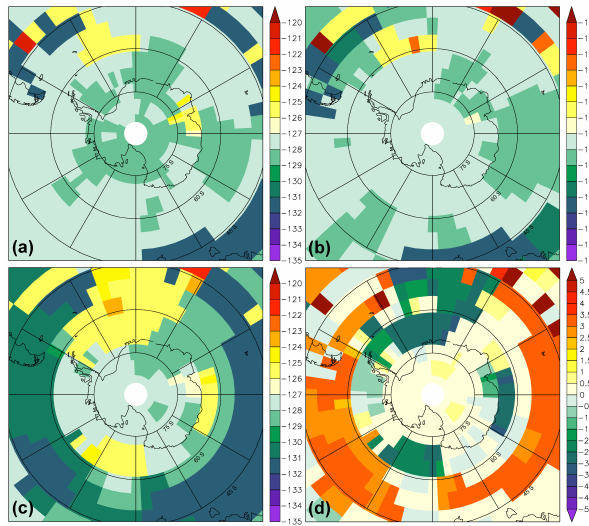
Figure 9. Time of maximum surface air temperature (MWT) in kyrBP for experiments Reference (a) , noGfwf (b) , and noAGfwf (c) and difference in MWT between experiments noGfwf and noAGfwf (d) in kyr, showing the shift of the MWT when Antarctic freshwater fluxes are